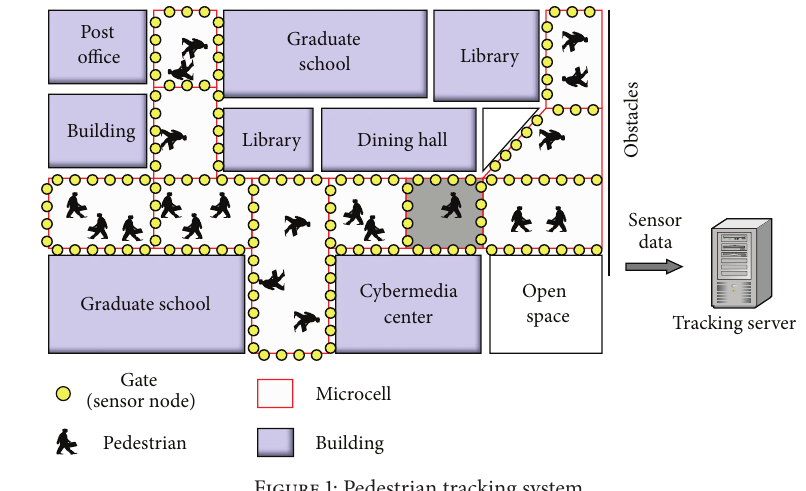
Figure 1: Pedestrian tracking system.